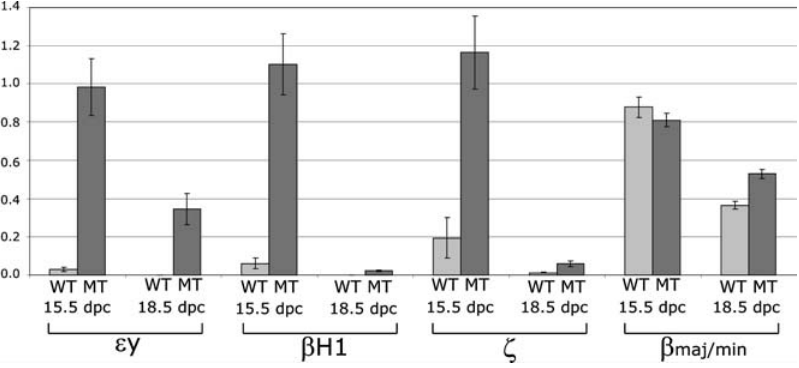
Figure 1. Real-Time PCR of Globin Genes The levels of expression of e y, b h1, zeta, and b maj/min were measured at 15.5 dpc and 18.5 dpc in homozygous WT and p 100H mutant littermates by real-time PCR (see Materials and Methods). Relative expression levels in the livers of each genotype are graphed for each globin gene (performed in triplicate and normalized with GAPDH). Standard deviation is indicated by bars. DOI: 10.1371/journal.pgen.0020014.g001